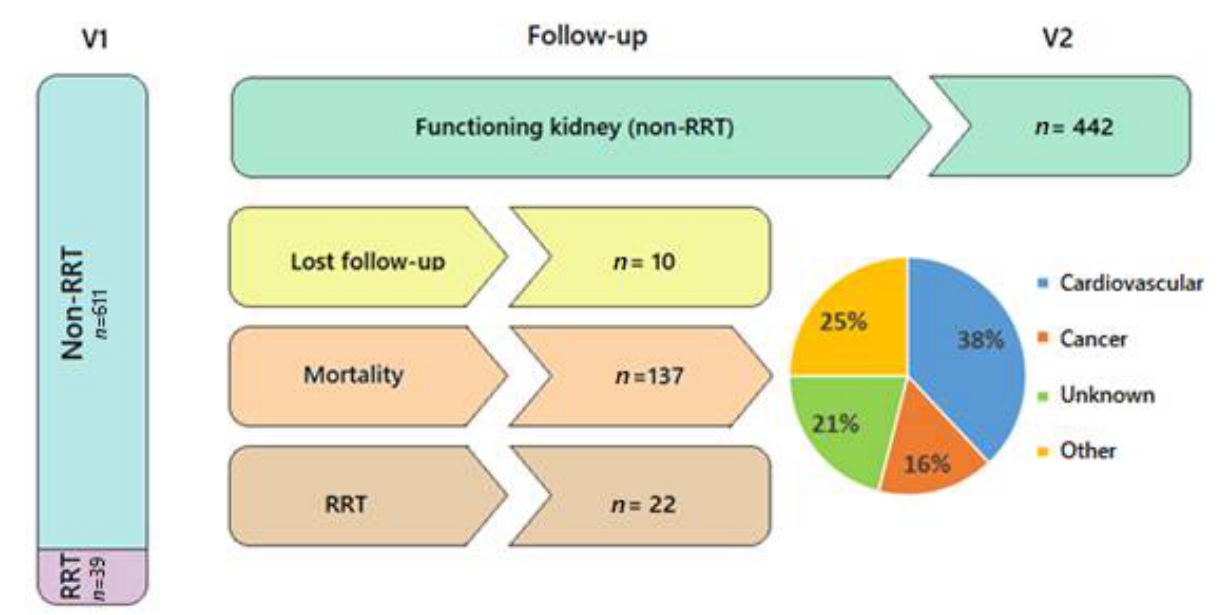
Figure 4. Flowchart depicting patients’ distribution during follow-up, their need for renal replace- ment therapy (RRT), mortality, and its causes. Pie chart shows causes of mortality distributed in percentages.